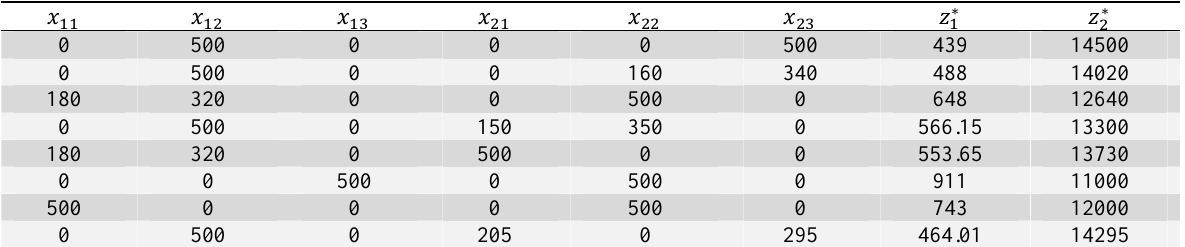
Different Pareto solutions